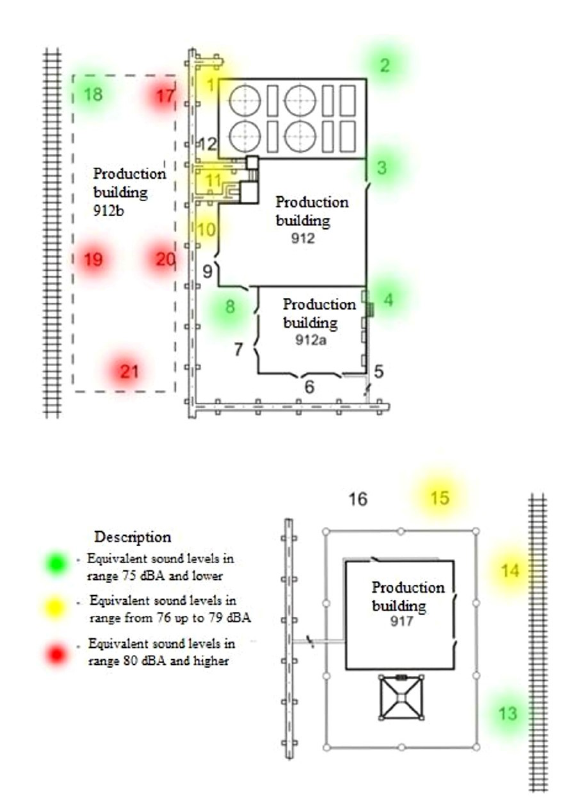
Figure 4: Map of equivalent sound levels during measurements at working places of shop 38 of "KuibyshevAzot" company